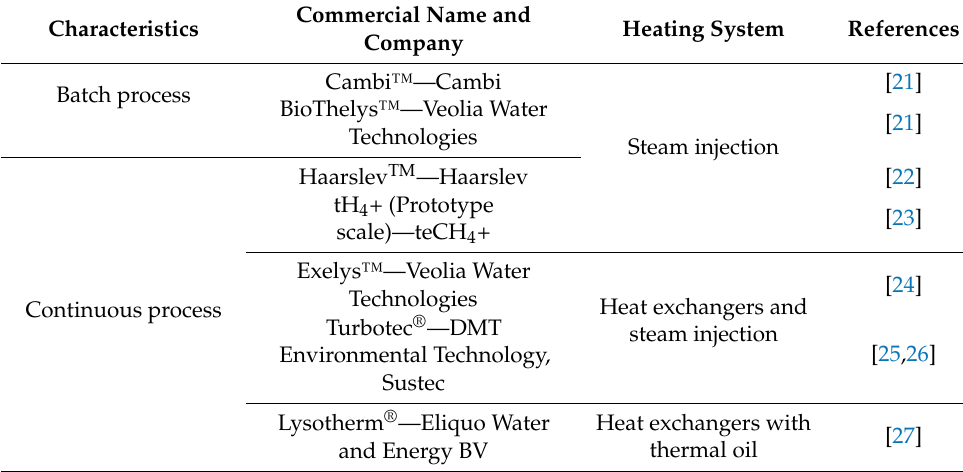
Table 2. Thermal hydrolysis processes at the commercial stage and close-to-commercialisation